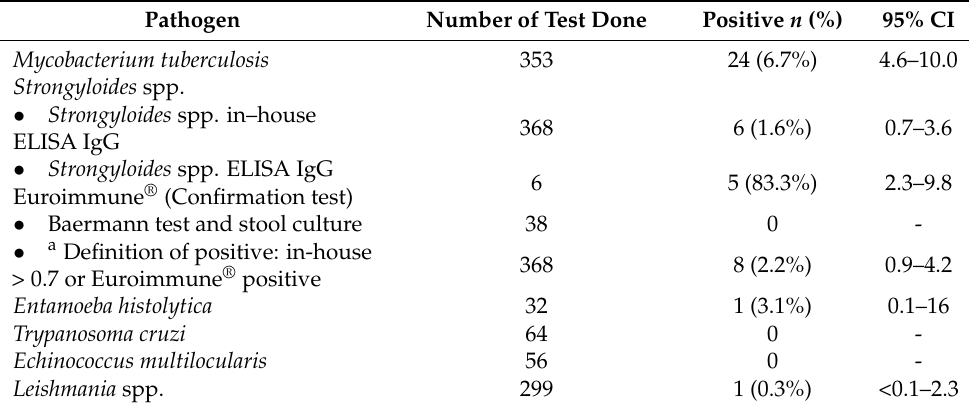
Table 3. Results of screening tests for latent tuberculosis and parasitic infections.